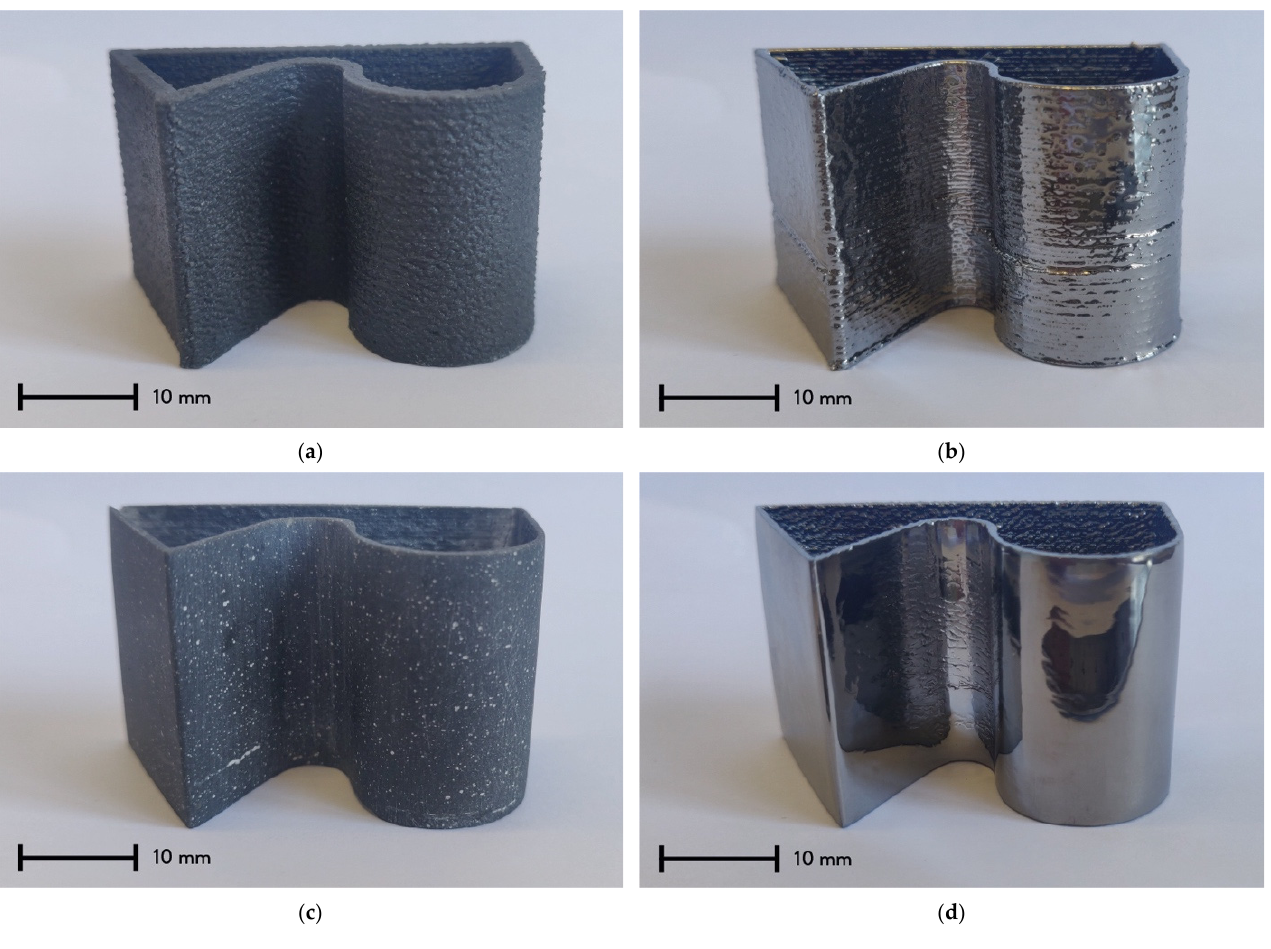
Figure 1. 3D-printed and metallized specimens from the different sample batches: ( a ) Batch n. 1 (no finishing, no PVD); ( b ) Batch n. 2 (No finishing, PVD); ( c ) Batch n. 3 (Finishing, no PVD); ( d ) Batch n. 4 (Finishing, PVD).